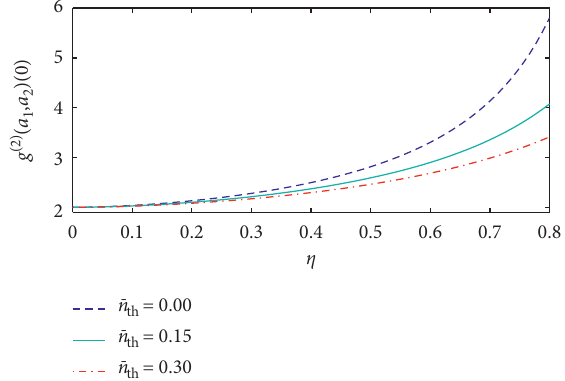
Figure 18: Plots of the normalized second-order correlation function (equation (41)) versus η for A � 100, κ � 0 . 8, ε � 0 . 399 and for different values of n th